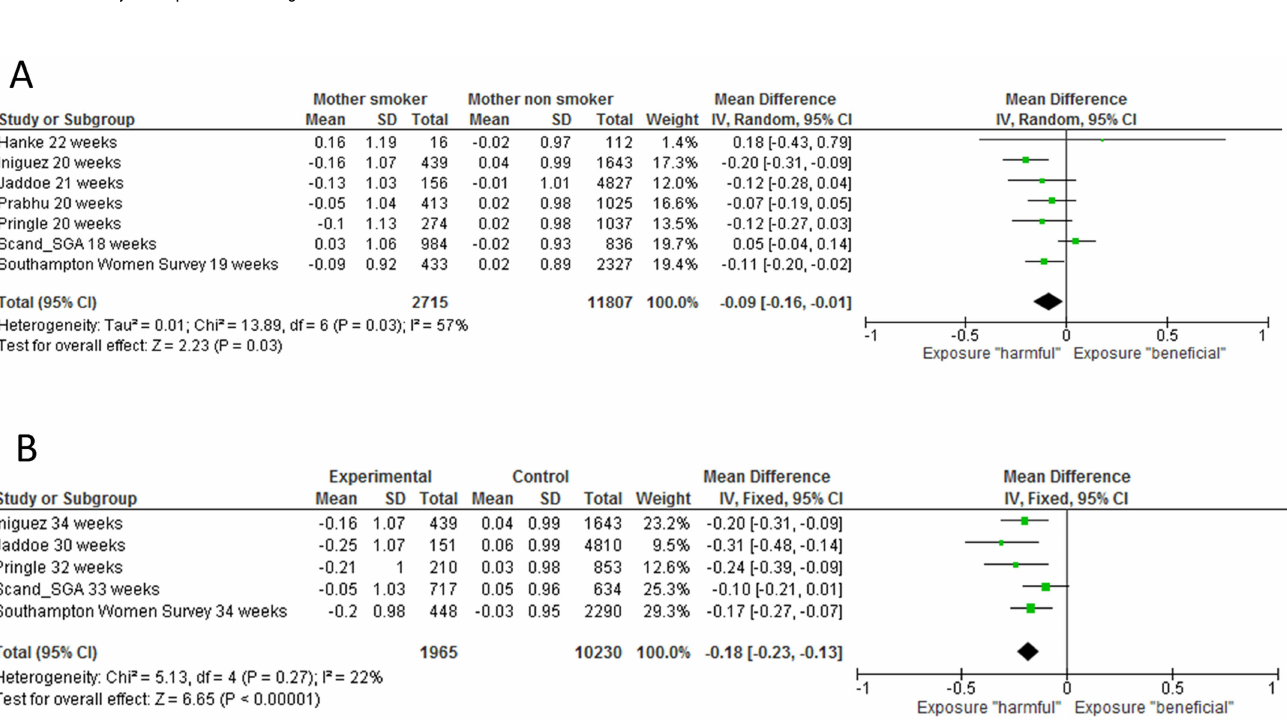
Fig 3. Forest plots demonstrating the association between maternal smoking and fetal head size (biparietal diameter or head circumference) in the second trimester (panel A) or the third trimester(panel